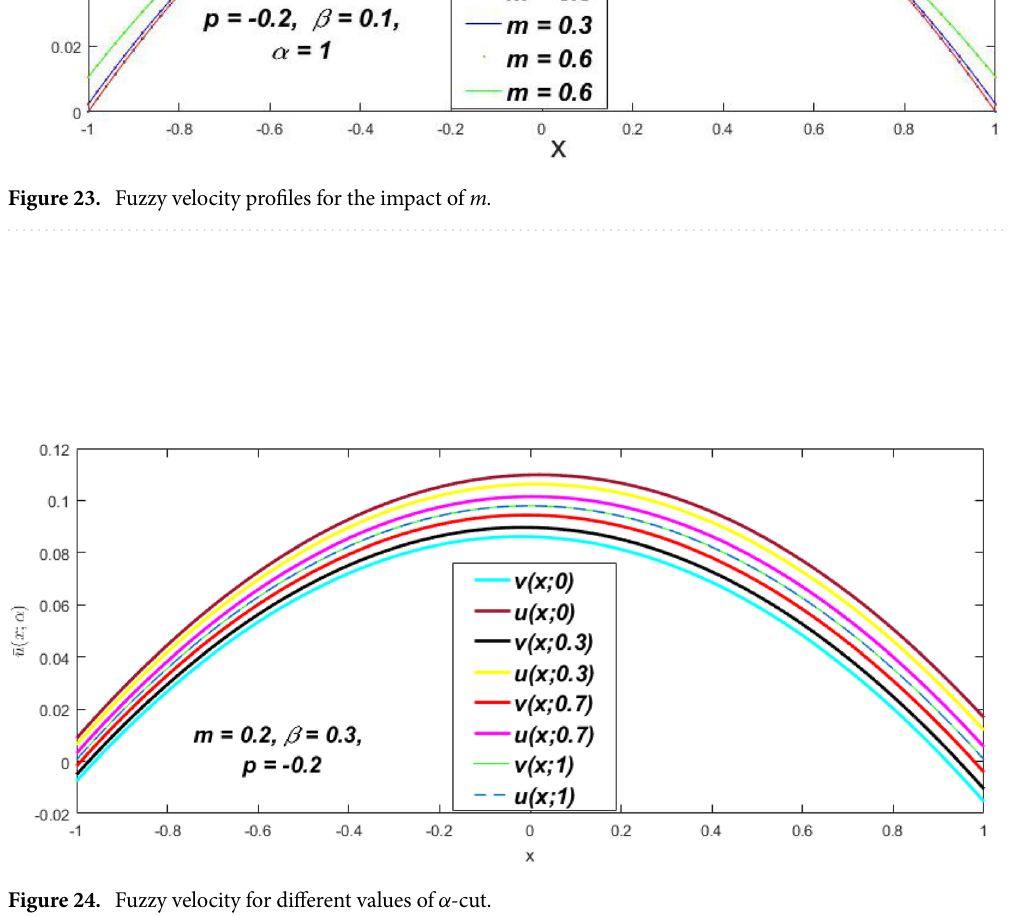
Figure 24. Fuzzy velocity for different values of α